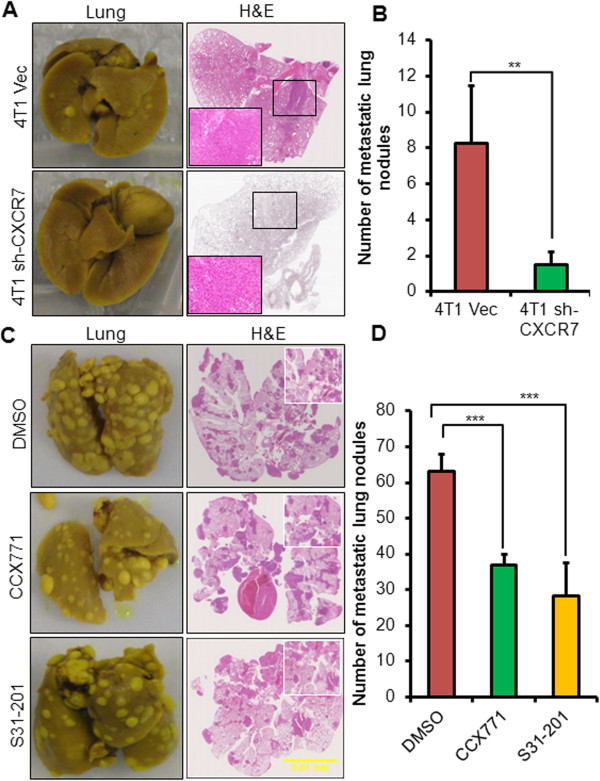
CXCR7 promotes breast cancer metastasis. Lungs were removed from mice used in the experiment presented in Figure 2 and inflated with Bouin fixative and number of metastatic nodules on the lungs was counted with the aid of a dissecting microscope. (A) H&E (2.5×) staining of metastatic nodules in the lungs of mice bearing 4T1 Vec or 4T1 sh-CXCR7 (insets: 20× magnification of the areas selected by rectangles) (B) bar showing the number of metastatic lung nodules and (C) H&E (2.5X) staining of metastatic nodules in the lungs of mice bearing 4T1.2 tumors treated with either DMSO or CXCR7 inhibitor (CCX771) or STAT3 inhibitor (S31-201) insets: 5× magnification and (D) bar showing the number of metastatic lung nodules. Scale bars, 0.01 mm. **p < 0.01, ***p < 0.001 versus control.